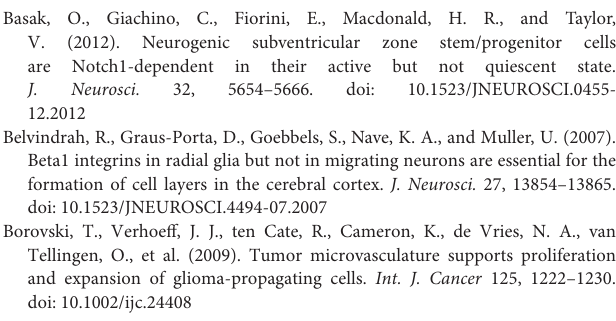
Supplementary Table 3 | Information relative to the secondary antibodies used in western